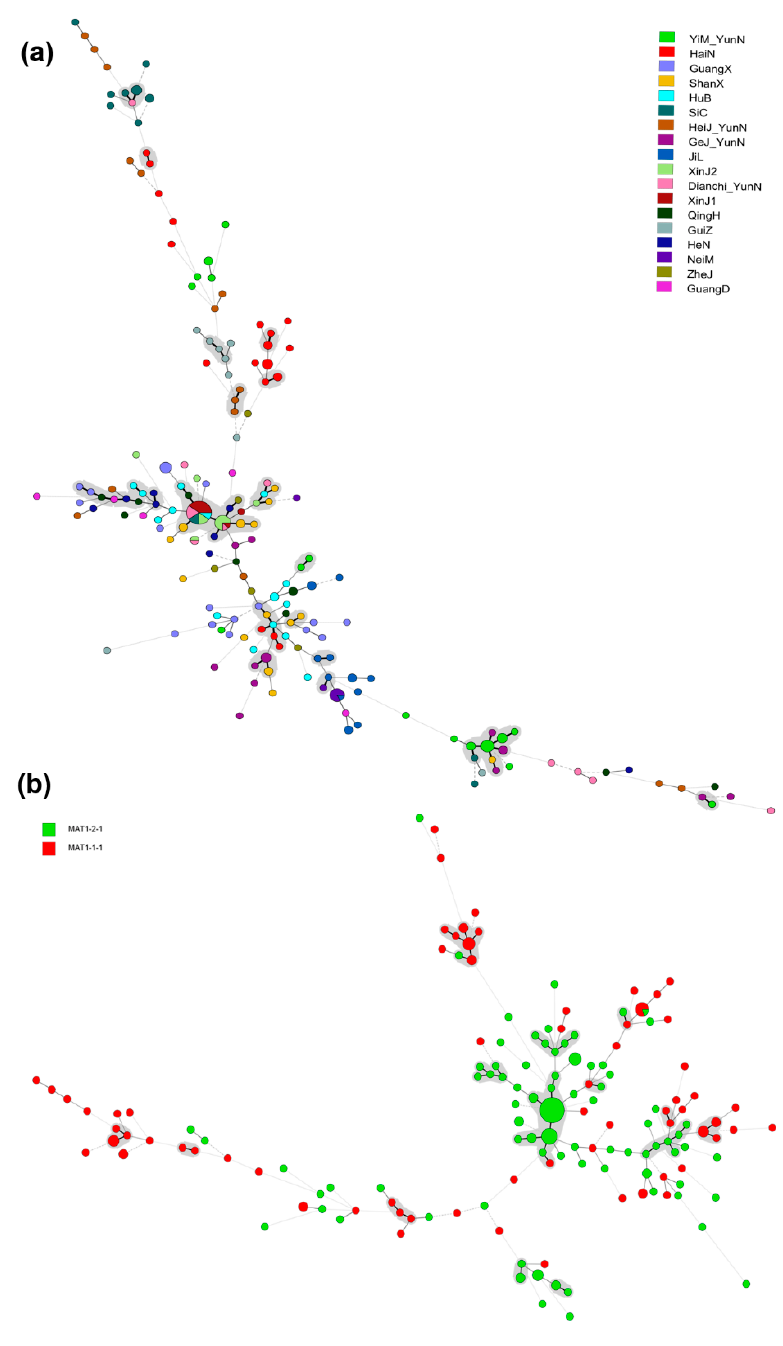
Figure 2. Minimum spanning tree (MST) showing the genotypic relationship ( a ) among different geographical populations and ( b ) between different mating types containing A. oligospora isolates. Notes: Each circle corresponds to a unique genotype, and the size of the circle proportionally represents the number of isolates with that genotype. Connecting lines correspond to the number of differences between the genotypes. Short bold line, 1 difference; black line, 2 differences; long grey line, 3 differences; dotted line, 4 or more differences.